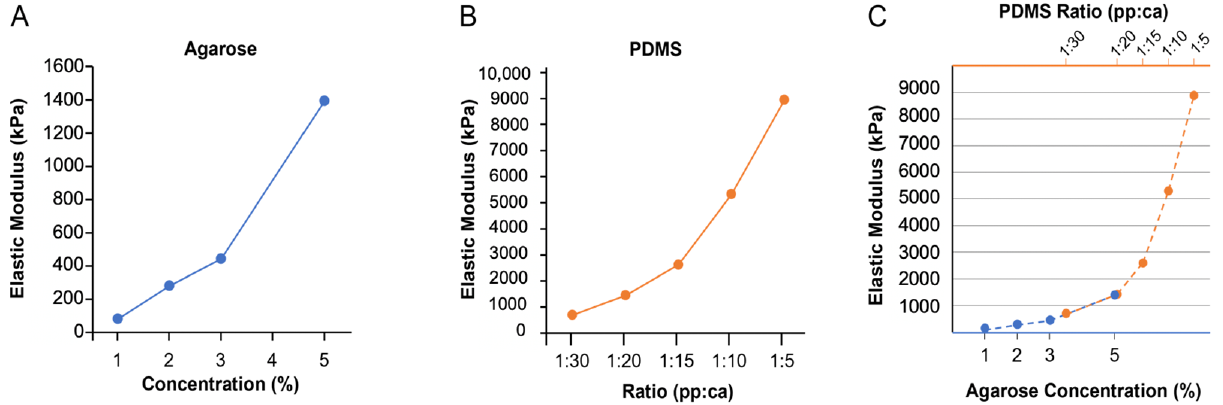
Figure 2. Elastic moduli of ( A ) agarose and ( B ) polydimethylsiloxane (PDMS). ( C )The elastic moduli of the agarose substrate at 3% and 5% overlaps with the PDMS substrate generated in a 1:30 and 1:20 ratio.